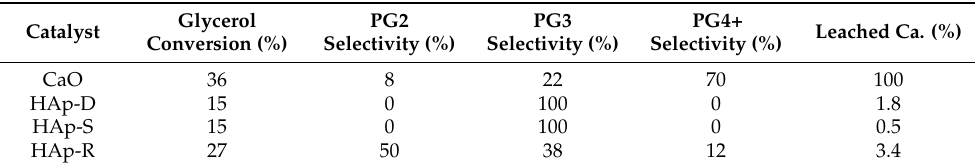
Table 1. Catalytic performances in glycerol polymerization reaction in the presence of 0.5 mol% of CaO and different HAps and percentages of leached Ca based on the ICP-OES when 0.5 mol.% of catalysts were used at 245 ◦ C for 8